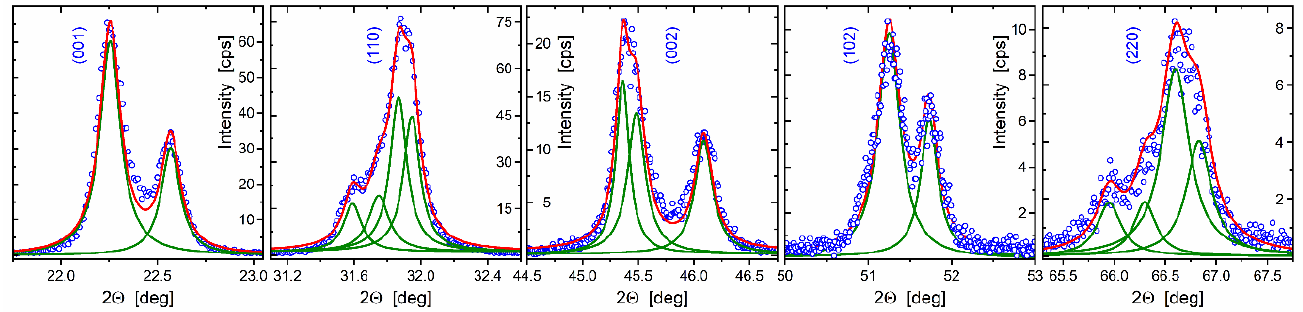
Figure 4. Circular symbols display enlarged Na 0.35 K 0.65 NbO 3 Bragg reflections from the experimental XRD scan in Figure 3. Green color solid lines depict fitting Lorentzian components whereas summarizing curves are shown with a red color.